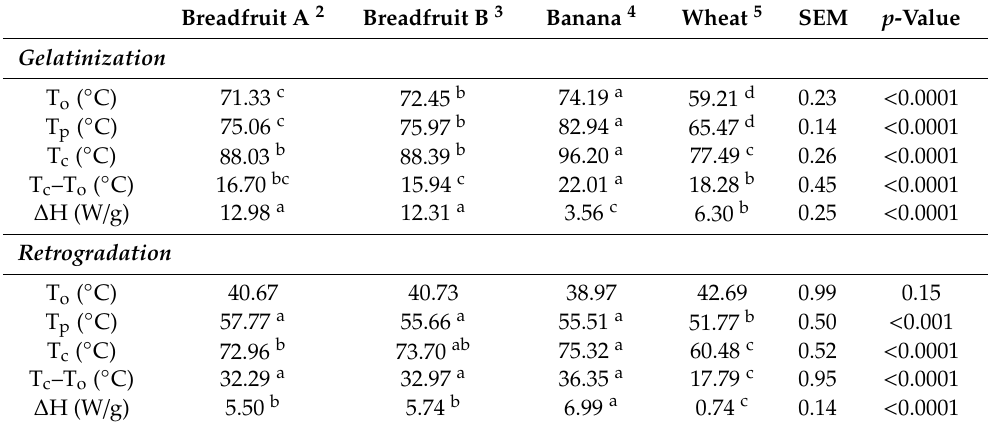
Table 3. Gelatinization and retrogradation properties of tropical flours compared with a traditional flour 1 . Breadfruit A 2 Breadfruit B 3 Banana 4 Wheat 5